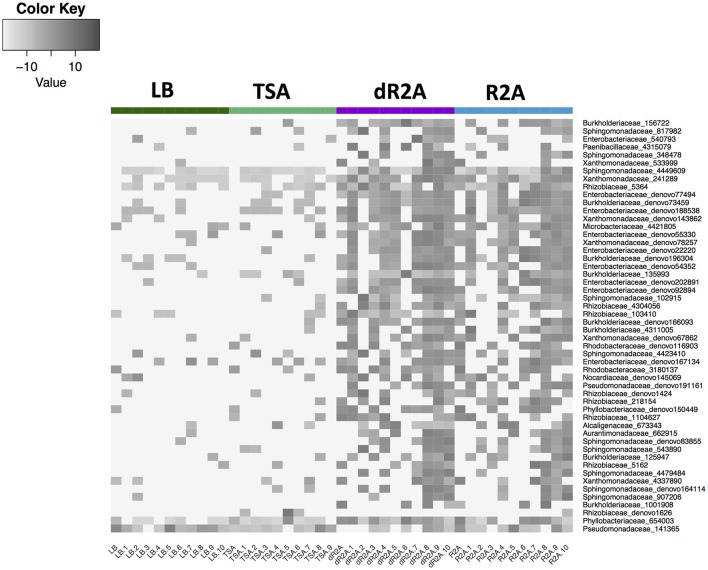
Heatmap of log-transformed relative abundances of the indicator OTUs associated with the different media types (LB, TSA, R2A, and dR2A). Rows indicate each indicator OTU family and ID, and columns indicate the individual toads/replicates within each culture media type.